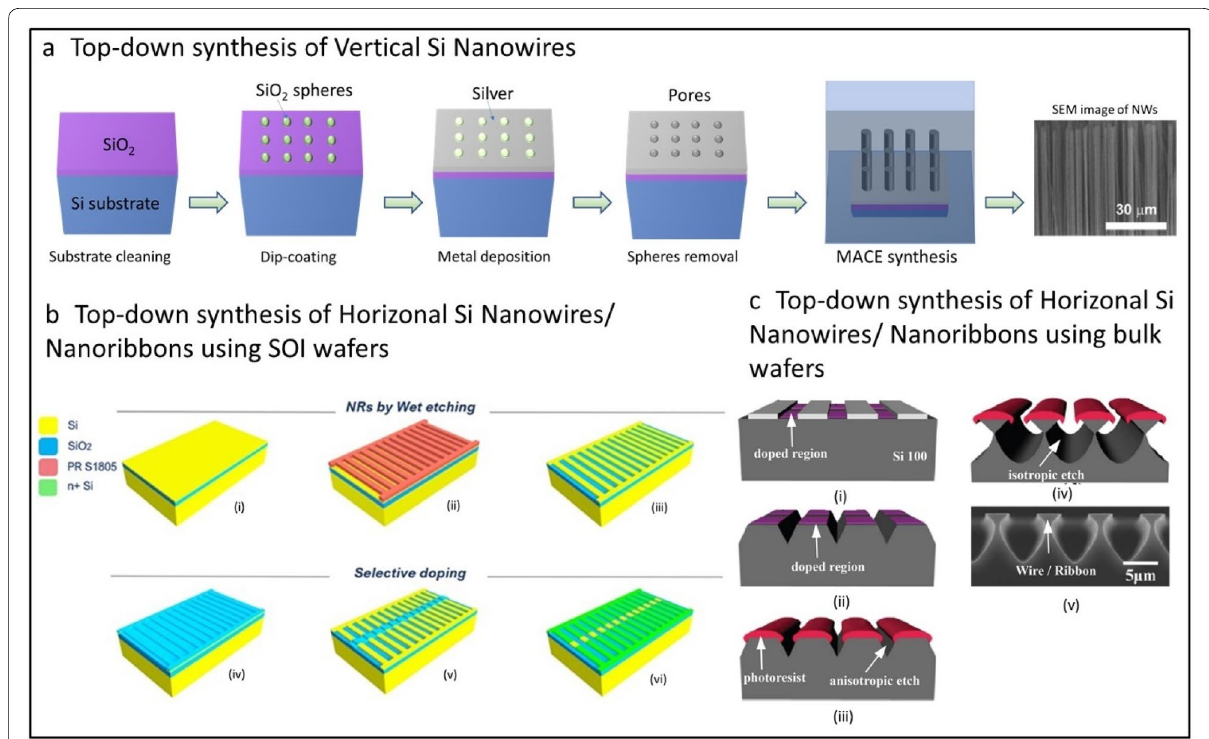
Fig. 4 Schematic representation of the growth of nano scale structures via top-down methods. a Silicon nanowires using metal assisted chemical etching (MACE) process. Schematics adapted from [59]. b Schematic diagram illustrates stages of the Si NRs fabrication and selective doping (i) The source wafer consists a layer of active Si < 100 > with 70 nm thick, on top of 2 µm of BOX, supported by 600 µm bulk Si. (ii) Si NR’s geometry is defined by conventional UV lithography procedure. UV lithography is performed by spin coating photoresist, followed by soft baking, the samples are exposed to UV source and subsequentially the NRs definition are developed. (iii) Dry etching is performed in this step by reactive ion etching (RIE) using a combination of CH 3 /O 2 gas sources, to finalize the structure of NRs structure after photoresist removal using acetone and IPA. (iv) The first step to perform a selective n type doping of active regions (source/drain for FETs) is by applying plasma enhanced chemical vapour + deposition (PECVD) of SiOx layer. (v) The SiOx barriers over the active regions are etched away by dry etching. (vi) Spin on dopant method of phosphorus is used to create ohmic contacts at source and drain regions on the source wafer while the channel is masked by SiOx, served as a barrier. A wet etching method using hydrofluoric acid is performed to remove both dopant diffusion barrier layer and buried oxide layer leading in release of the NRs from the bulk wafer, allowing the selectively doped NRs to be transfer printed to any flexible substrate. Adapted with permission from [46]. c Schematic illustration of the fabrication of NWs/NMs by use of anisotropic wet-chemical etching techniques applied to bulk